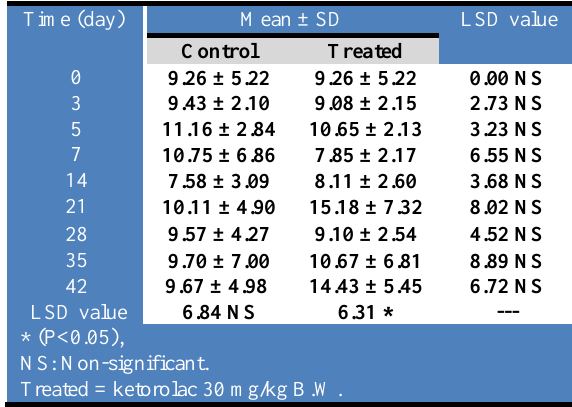
Table, 8: Shows White Blood cells count (×10*9/L) control and ketorolac treated